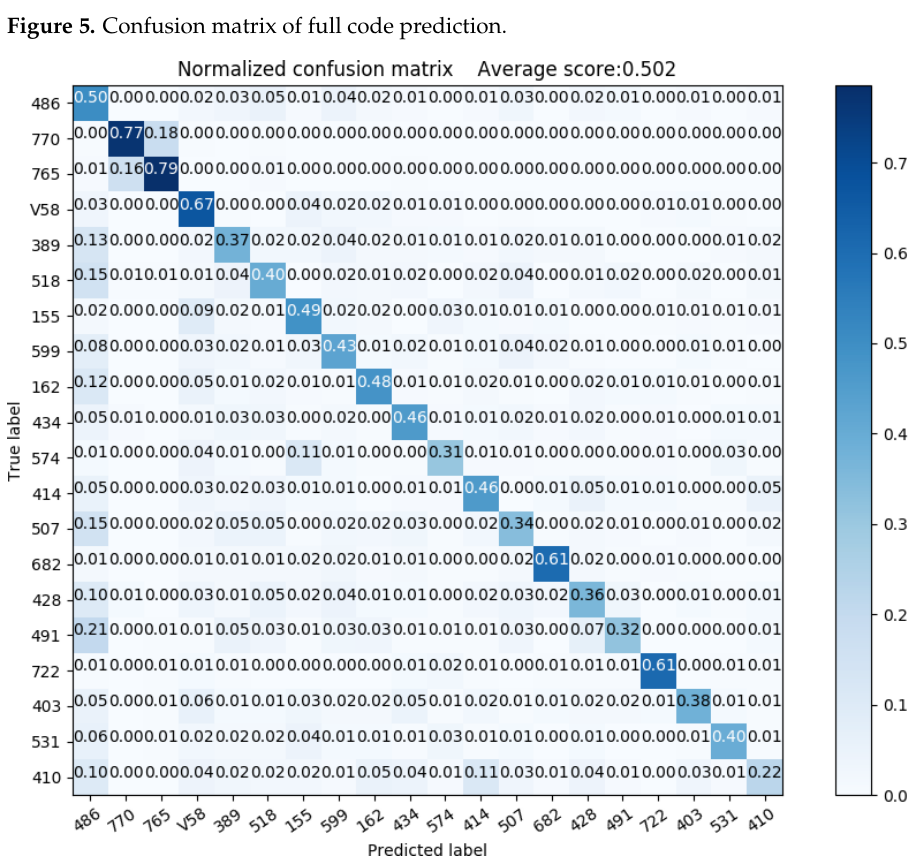
Figure 5. Confusion matrix of full code prediction.